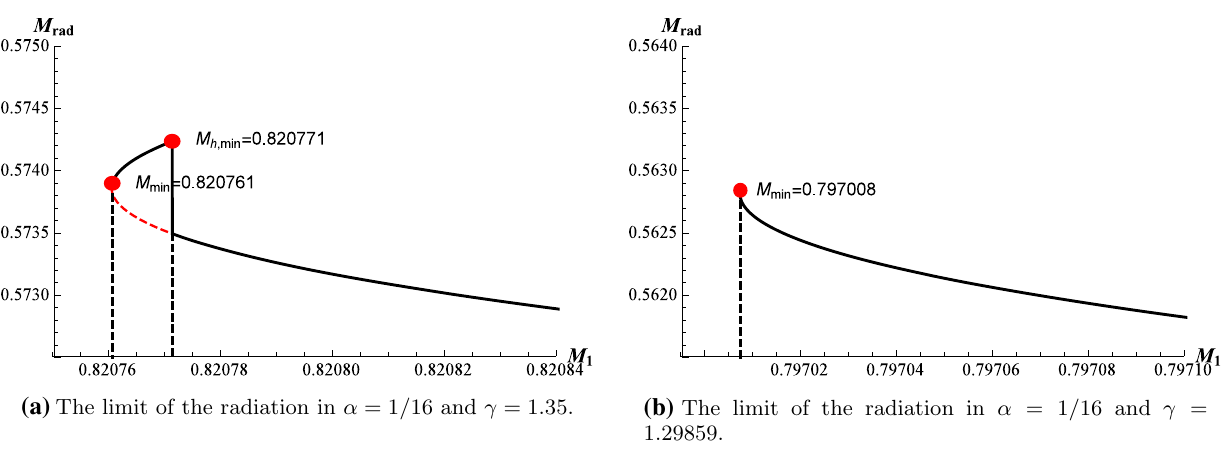
( a ) Overall behaviors of the limits of the radiation in α = √ 1 / 16 and γ = 2. Fig. 3 The upper limits of the radiation for the collision of two dilatonic black holes